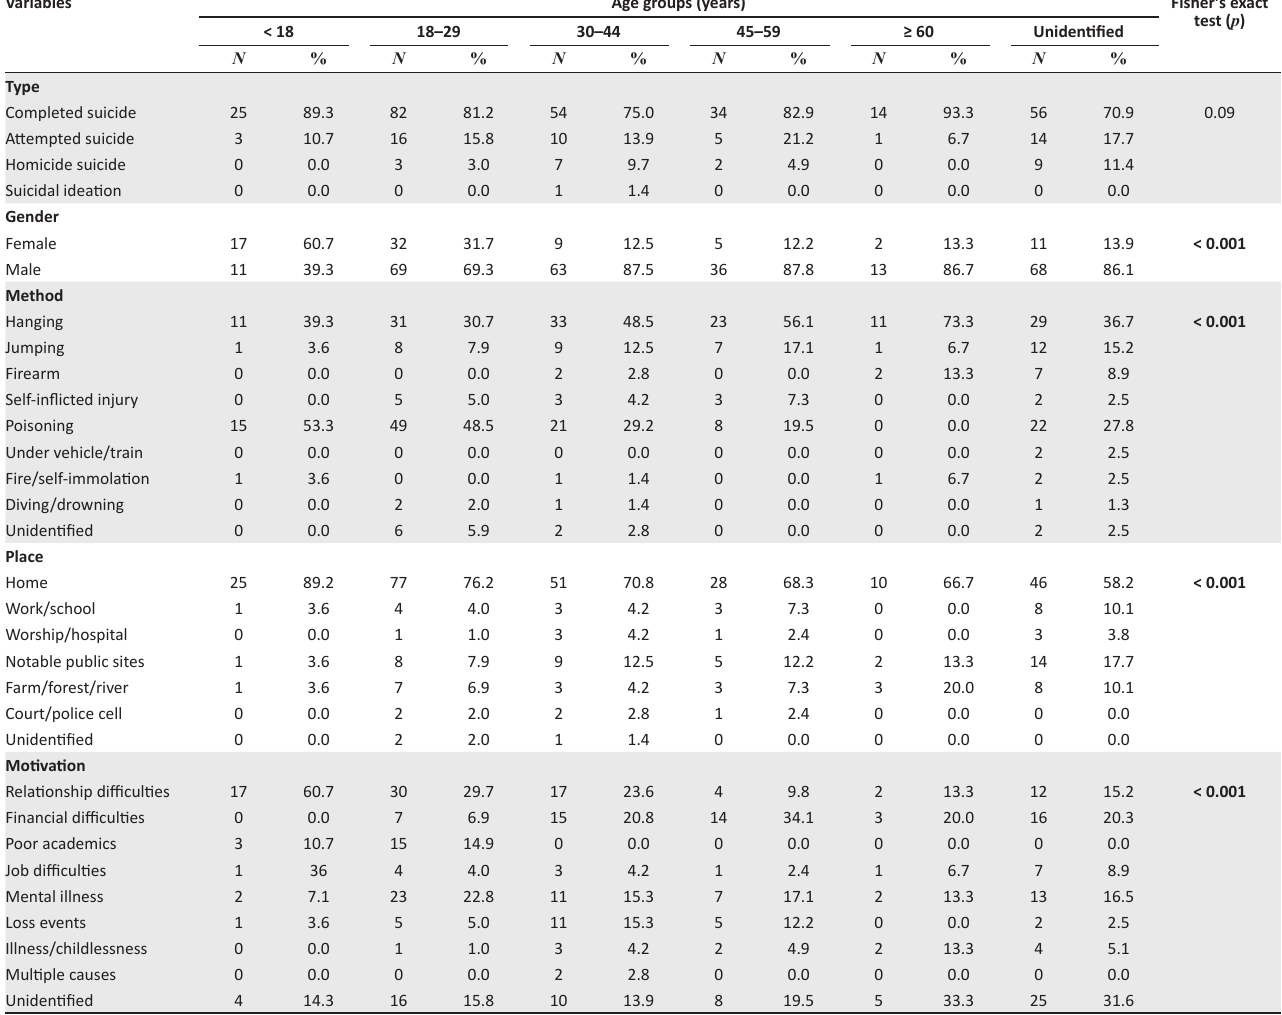
TABLE 4: Age group and type of suicide events, gender, method, place and motivation.